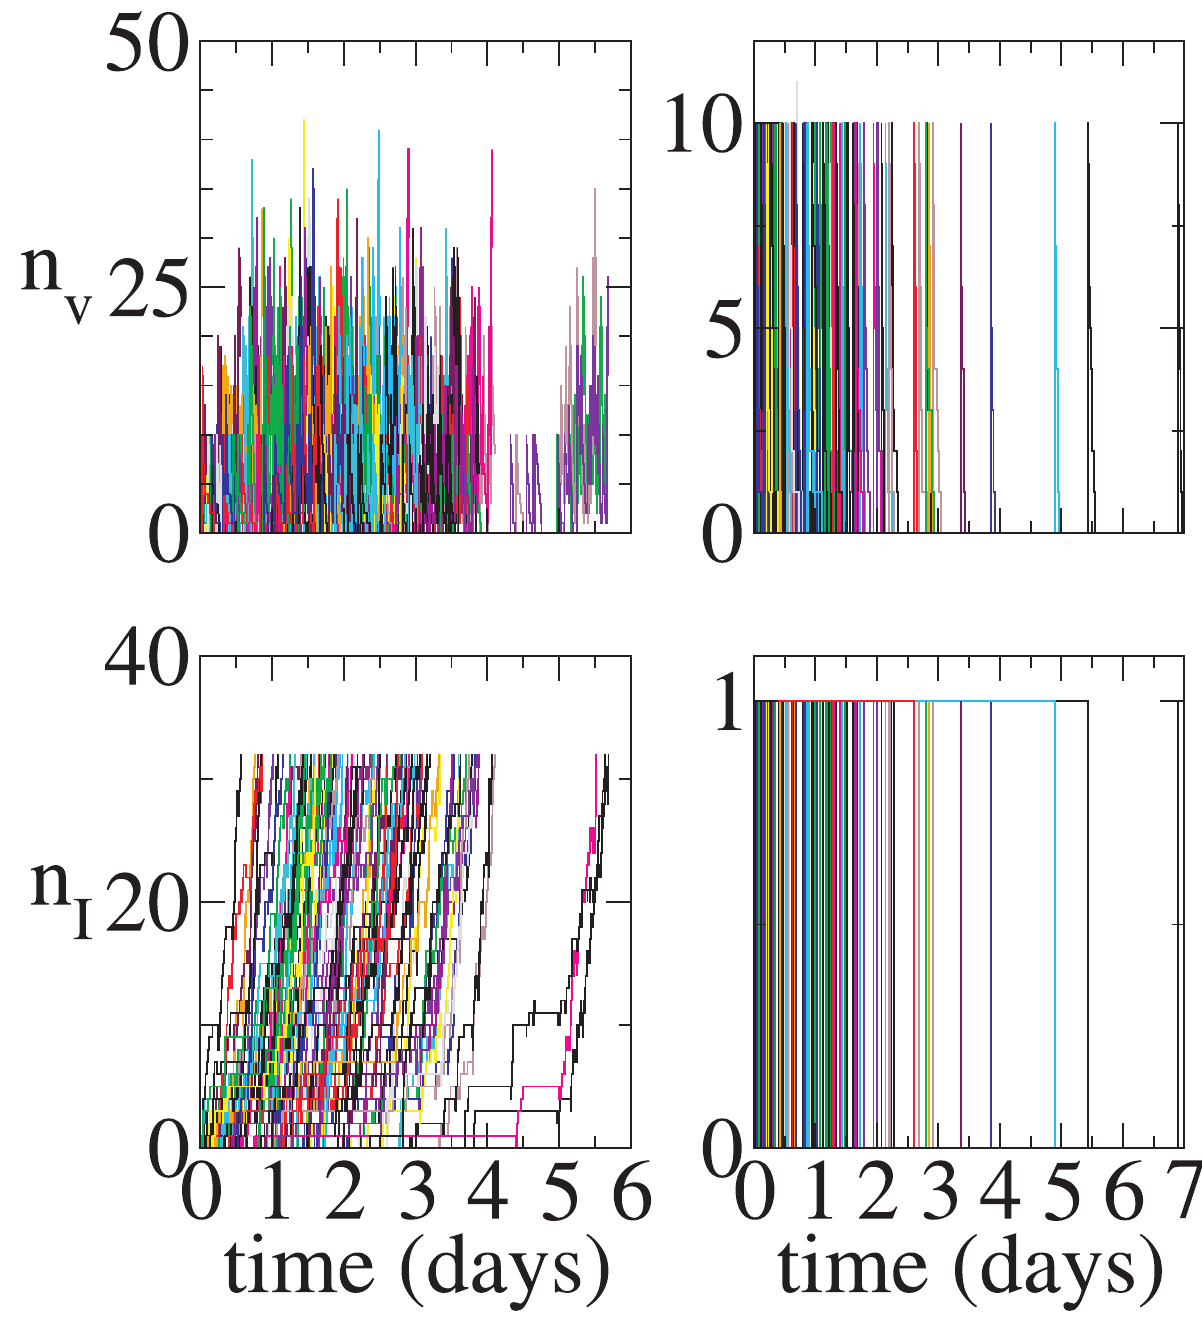
Figure 8. Burst model. Representative time series. Initial condition: n V ~ 0 , n I ~ 1 . Left column: 100 realizations that lead to infection. Right Column: 100 realizations that lead to